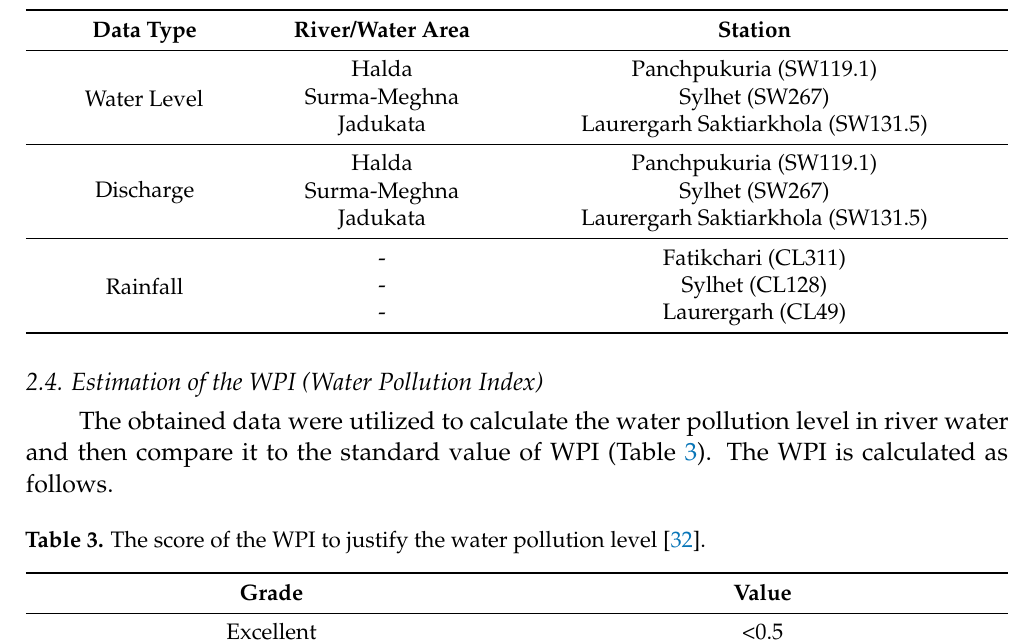
Table 2. The brief scenario of the environmental data collection sites.